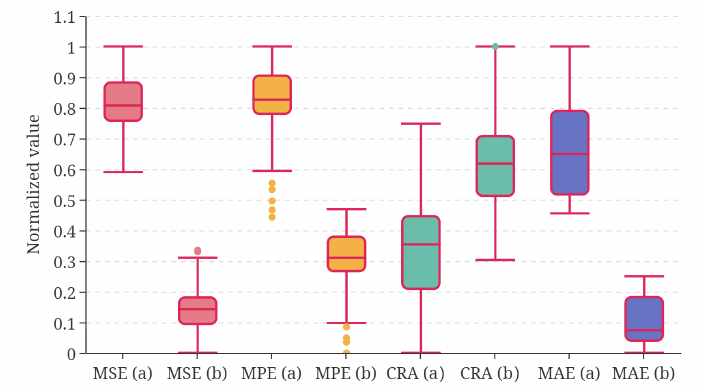
Figure 13. Result of RUL prediction for the next 128 s with disturbance and noise. a and b represent the TF and multilevel fusion TF,